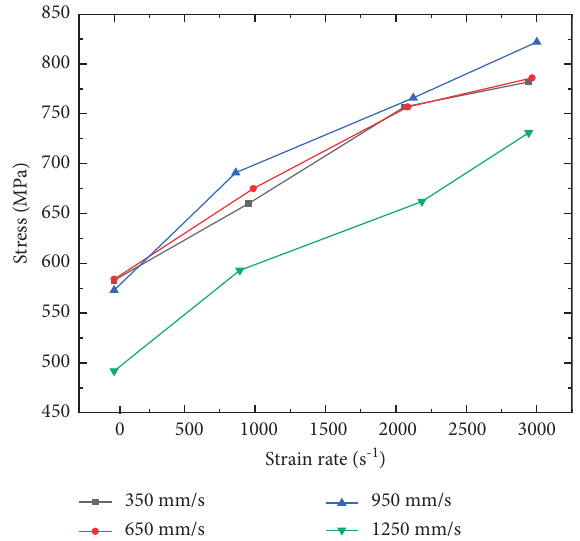
Figure 7: The peak yield strength of four scanning speed specimens under different loading strain